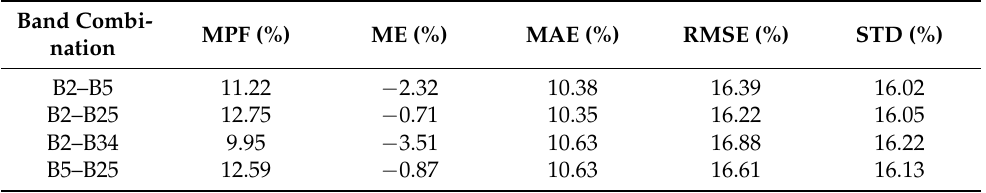
Table 1. The errors for the MPF retrieval results of the four band combinations between L8 and S2.